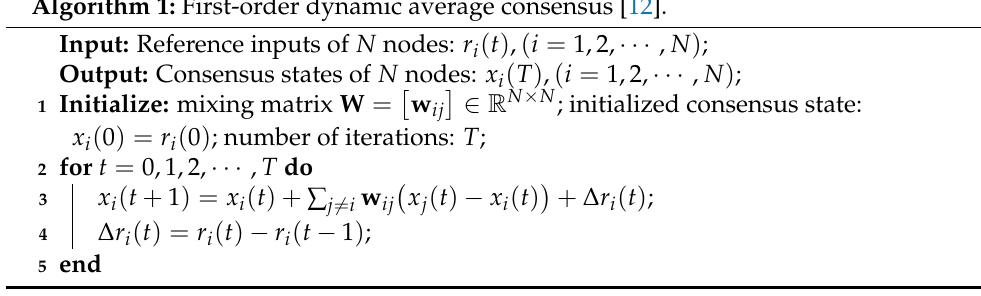
Algorithm 1: First-order dynamic average consensus